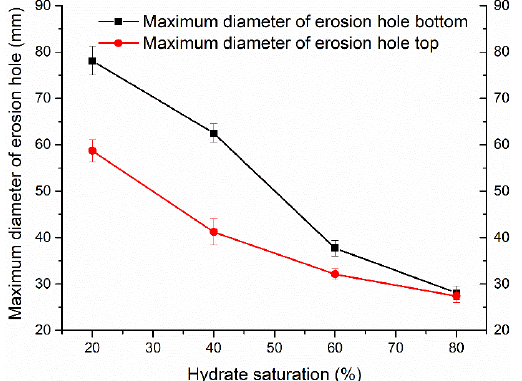
Figure 9. The influence of hydrate saturation on the maximum diameter of the erosion ‐ hole top and the maximum diameter of the erosion ‐ hole bottom.